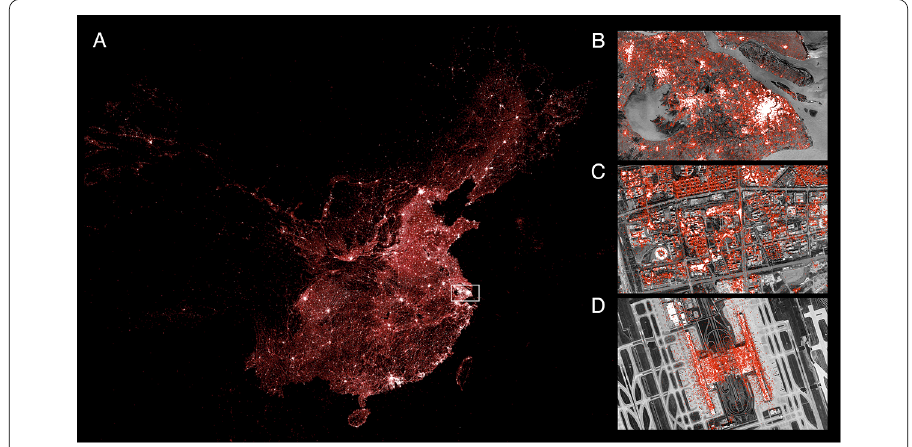
Figure 1 Spatial-temporal big data reflects human activity at different scales. (A) At the national level: Data points depict the fact that most of China’s population is concentrated in large cities in the east. As the brightness of the spot increases, the aggregation of the data points (population) increases. (B) At the regional level: This figure shows urban clusters in the Yangtze River Delta. (C) At the zone level: Zhangjiang Hi-tech Park in Shanghai. (D) At the building level: Pudong Airport in Shanghai. Maps were created using C and Datamaps (https://github.com/ericfischer/datamaps), and the remote sensing images were derived from Baidu